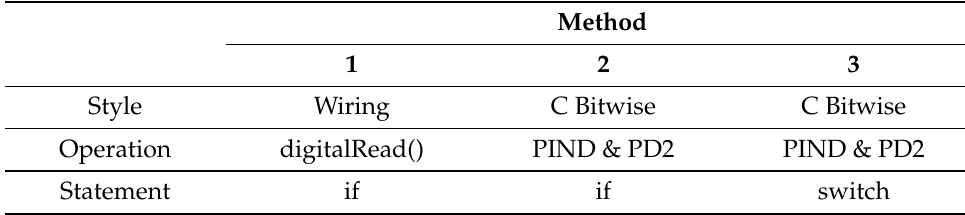
Table 2. List of three methods for PEDD software